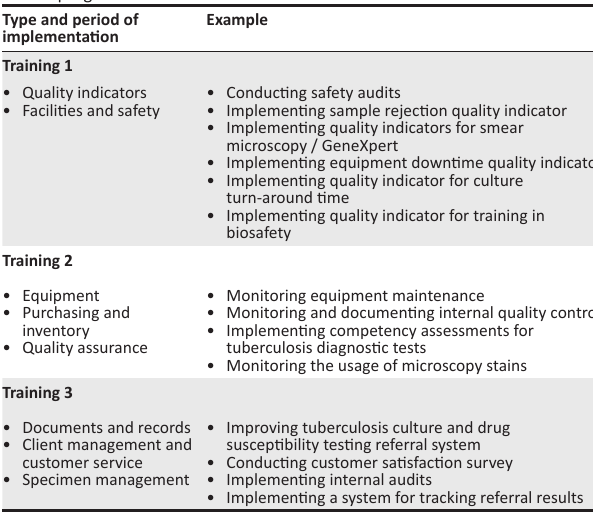
TABLE 2: Examples and types of improvement projects implemented in the TB SLMTA